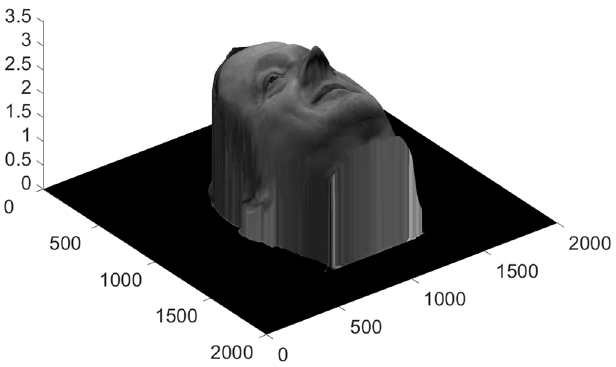
Figure 10. 3D object restored by means of the inverse Fresnel transform from the SLFP minus fi rst order spectrum.